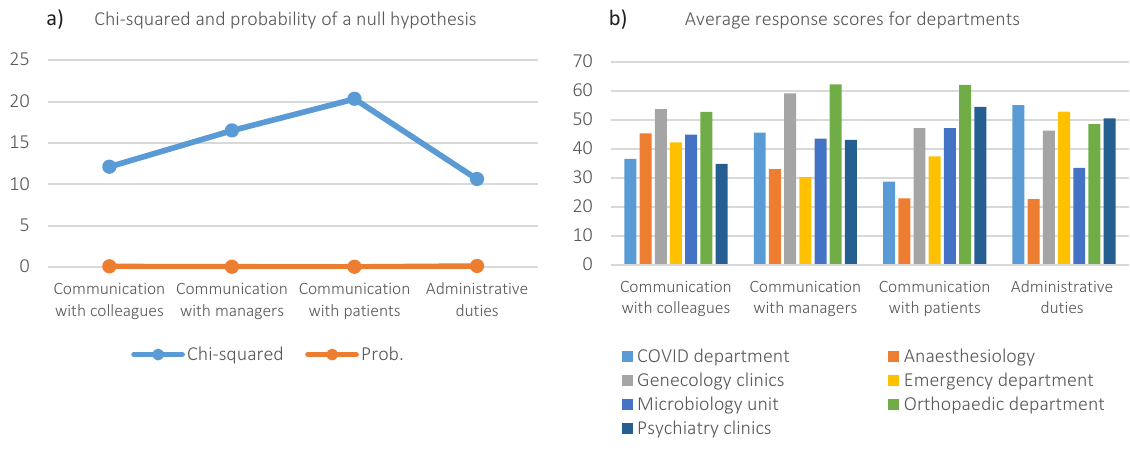
Figure 2. Significant differences between responses of hospital departments (professions) on work conditions